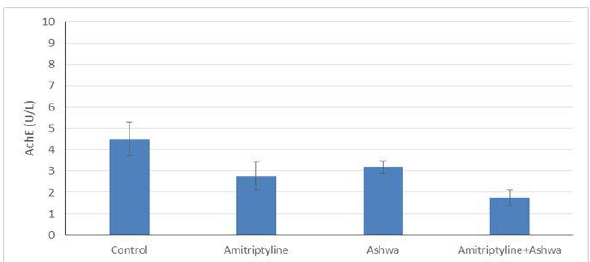
Fig.4: Acetyl cholinesterase enzyme (AchE) levels (U/L) at day 30. D